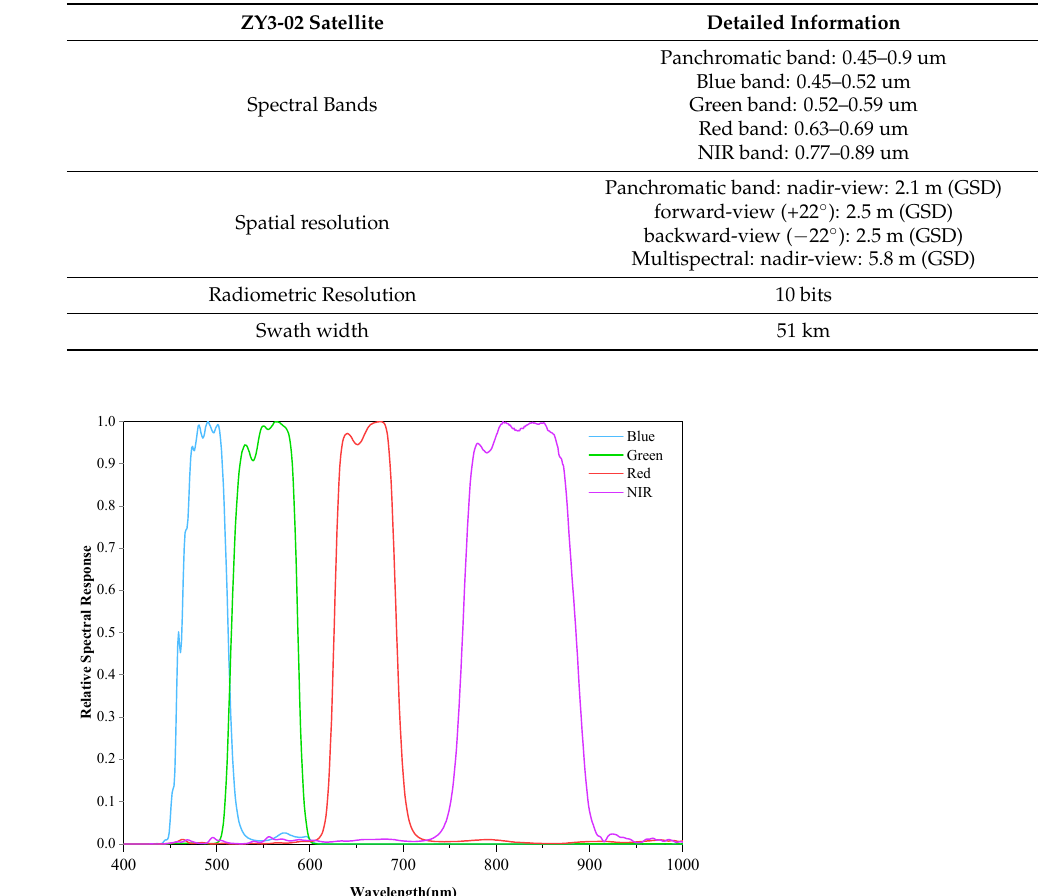
Table 1. Details of ZY3-02 satellite.